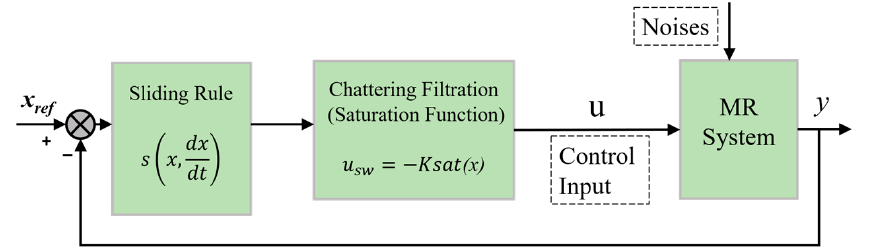
Figure 7. Sliding mode controller block diagram [26]. Reproduced with permission from Choi, S.-B. et al. State of the art of control schemes for smart systems featuring magnetorheological materials; published by Smart Materials and Structures, 2016.